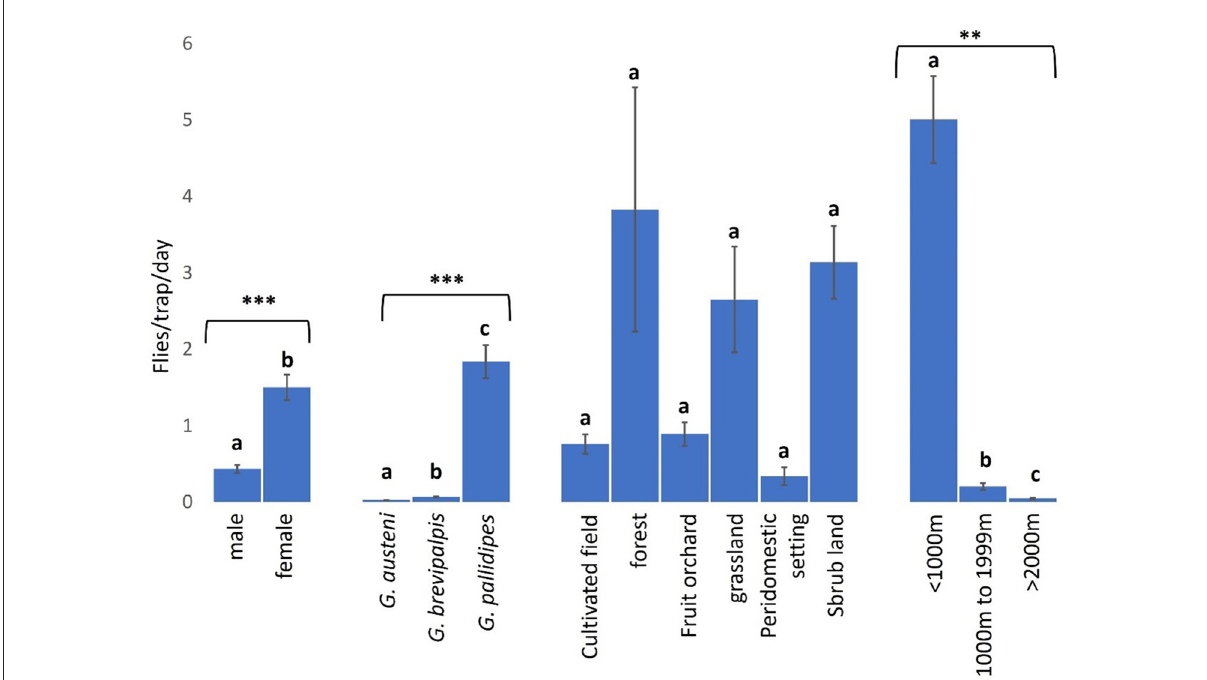
FIGURE2 Abundance of tsetse flies according to fly sex and species, and collection sites (landscape type and proximity to Shimba Hills National Reserve). *** and ** correspond to P values < 0.0001 and < 0.01 respectively. Error bars are used to indicate the standard error of the mean (SEM). Letters have been used to indicate presence or absence of significant difference in pairwise comparisons of tsetse fly abundance. Pairwise comparisons are made between tsetse flies within the same group defined by sex, species, vegetation site or distance from the wildlife reserve. Significantly different pairs are denoted using different letters while insignificantly different pairs are indicated using same